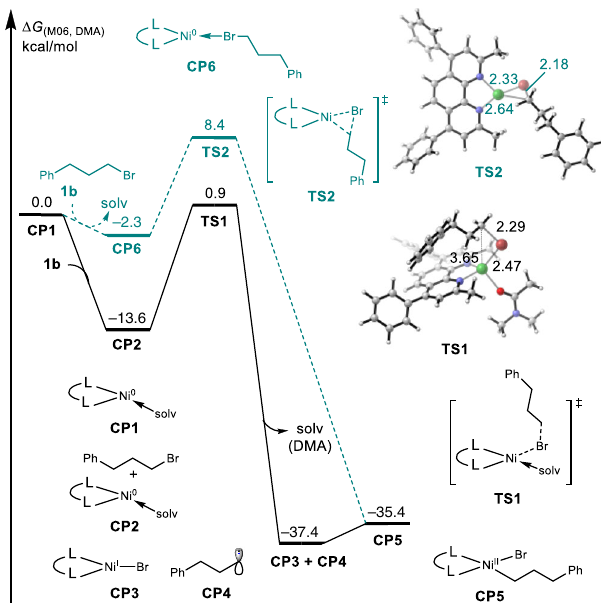
Fig. 6 The calculated reaction energy pro fi le of alkyl-Ni(II) complex formation steps. Energy values are given in kcal/mol and represent the relative free energies calculated by the M06 method in N , N -dimethylacetamide. The values of bond length are given in